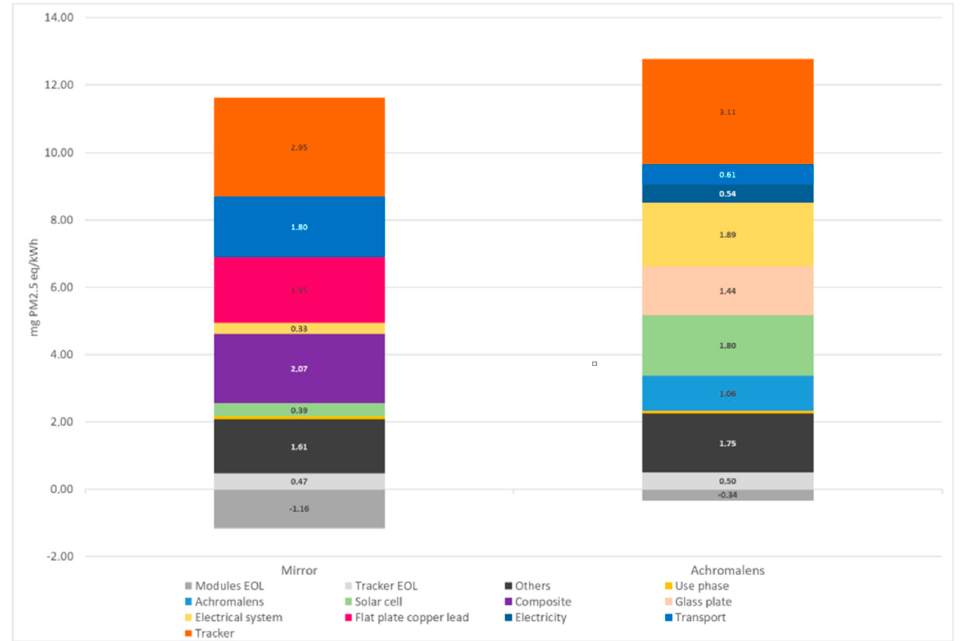
Figure 3. Impact on human health due to small particle emissions. Most impacting are the mirror and Achromalens module components’ and life cycle stages’ contribution to particulate matter. All processes contributing to more than 5% are detailed. Less significant contributors are gathered in the “Others” category. The total impacts potential is 11.8 and 12.4 mg PM 2.5 -eq/kWh, respectively, for the mirror and the Achromalens systems. Environmental benefits due to system extension thanks to metal recycling are responsible for the negative impacts.